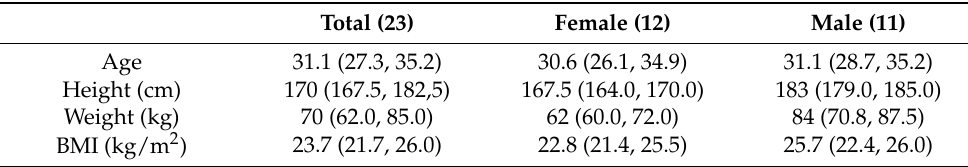
Table 1. Baseline